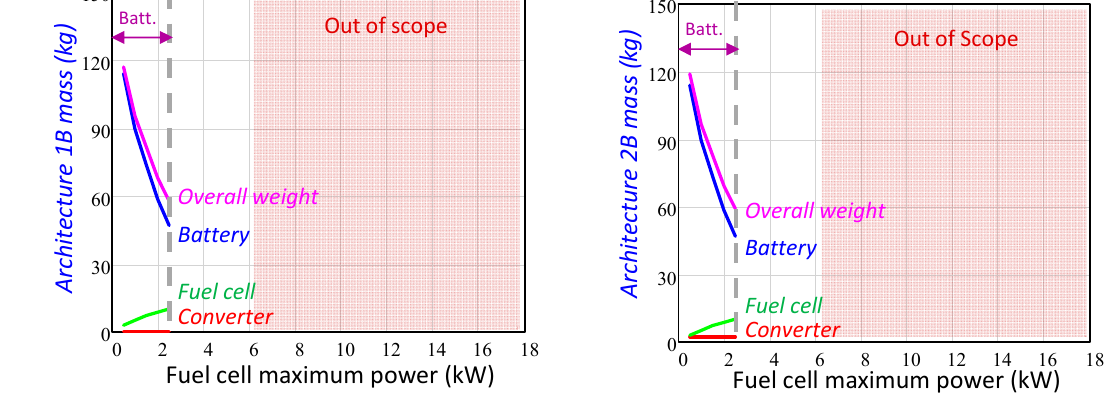
Figure 13. Architectures 1B and 2B mass.